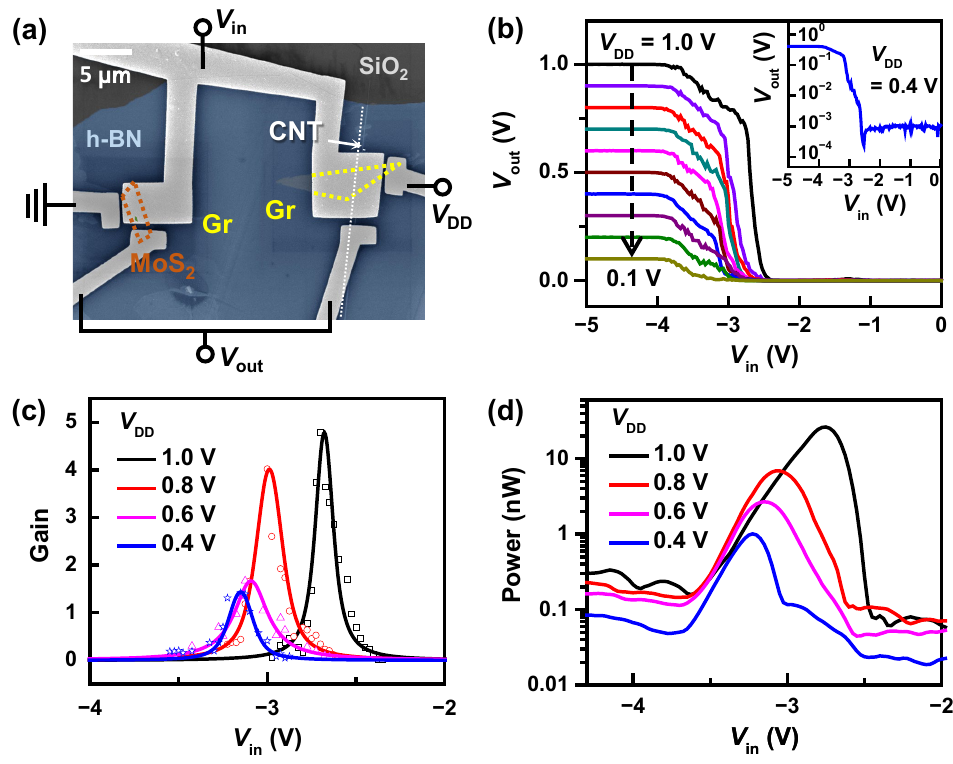
Figure 2. Inverter characteristics. ( a ) Scanning electron microscope image of Gr/MoS 2 (left) and Gr/CNT (right) junctions used in a complementary inverter. Dotted lines indicate the location of 2D layers and CNT. Both junctions are covered by a 15 nm-thick h-BN flake. ( b ) Voltage transfer characteristics of the complementary inverter at different V DD . The inset shows the voltage transfer curve at V DD = 0.4 V in a semilogarithmic scale. ( c ) Voltage gain as a function of the input voltage V in . ( d ) Power consumption of the complementary inverter versus V in in a semilogarithmic